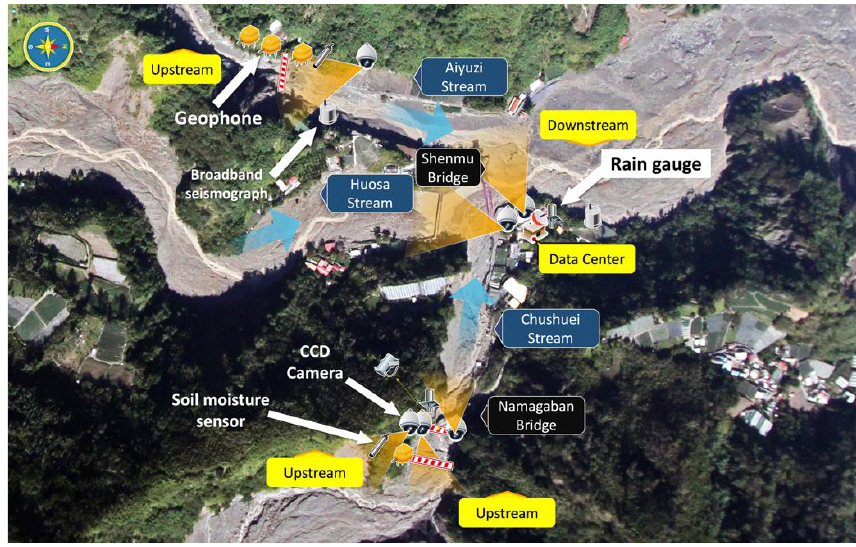
Figure 2. The layout of monitoring devices in the Shenmu area. Table 2. Specification of geophone OYO Geospace GS-20DX [22].